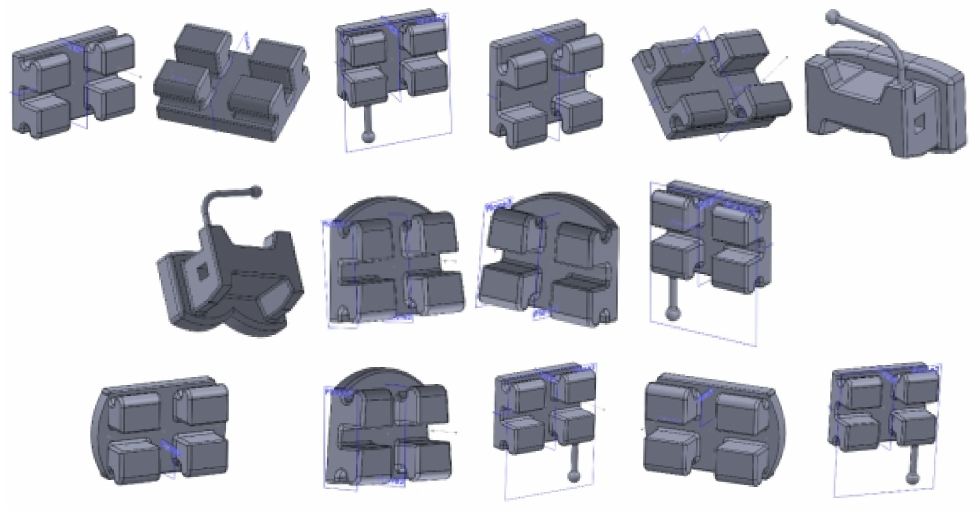
Figure 12. Virtual models of bracket and tube elements.